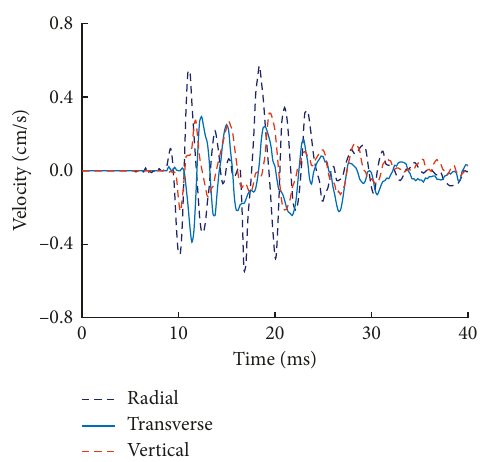
Figure 4: Velocities of single-hole